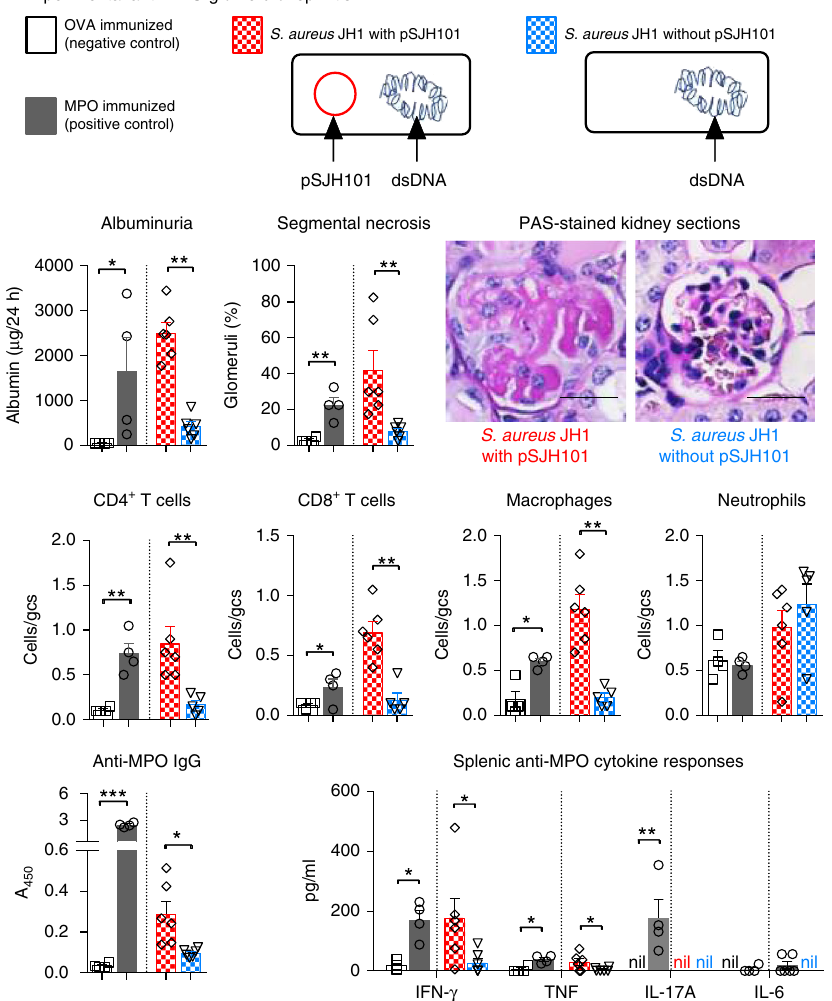
Fig. 8 Experimental anti-MPO glomerulonephritis in mice injected with S. aureus containing pSJH101 6PGD 391 – 410 . C57BL/6 mice were immunized with either OVA (negative control, n = 4), MPO (positive control, n = 4), S. aureus JH1 with pSJH101 ( n = 6) or cured S. aureus JH1 without pSJH101 ( n =